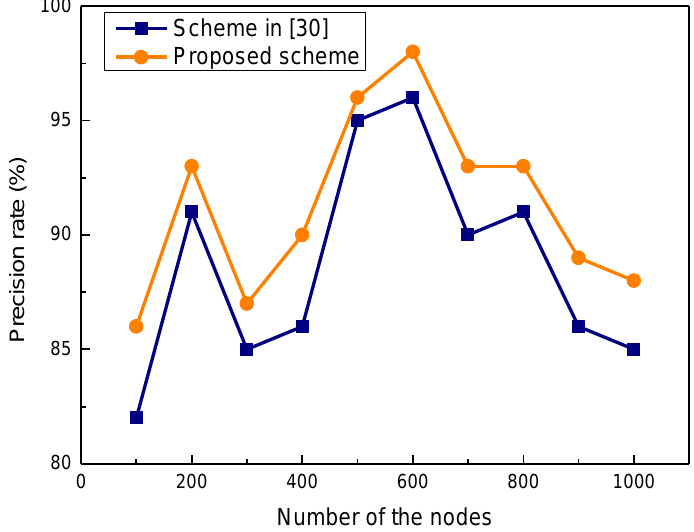
Figure 5. Precision comparison of security recommendation.